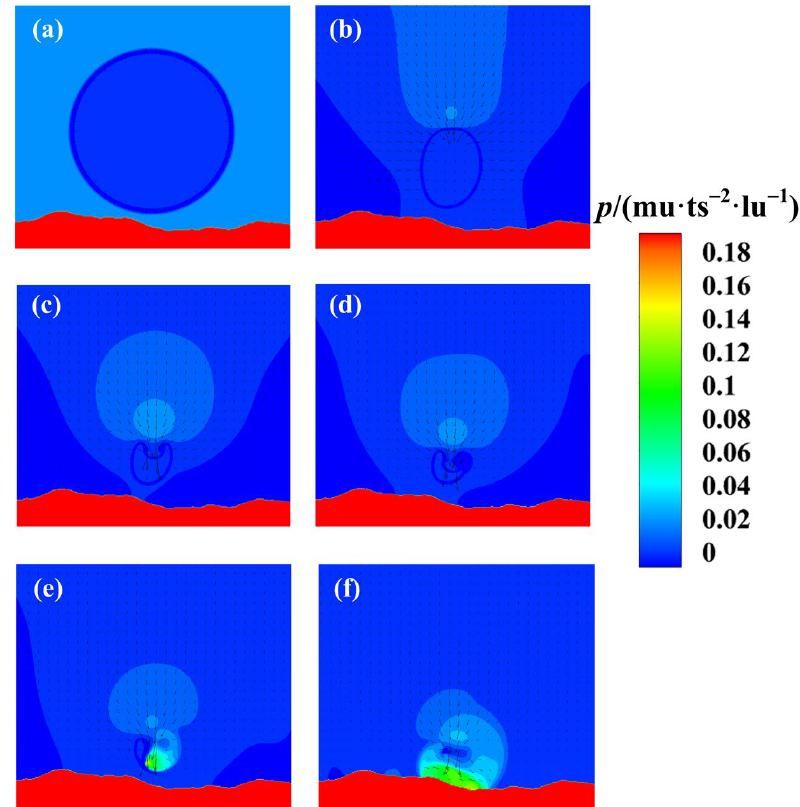
Figure 7. Evolution of pressure and velocity fields of the collapsing bubble near a solid wall with complex geometry for λ = 1.5 and D = 1.03476: ( a ) t = 0, ( b ) t = 550 ts, ( c ) t = 670 ts, ( d ) t = 705 ts, ( e ) t = 735 ts, and ( f ) t = 770